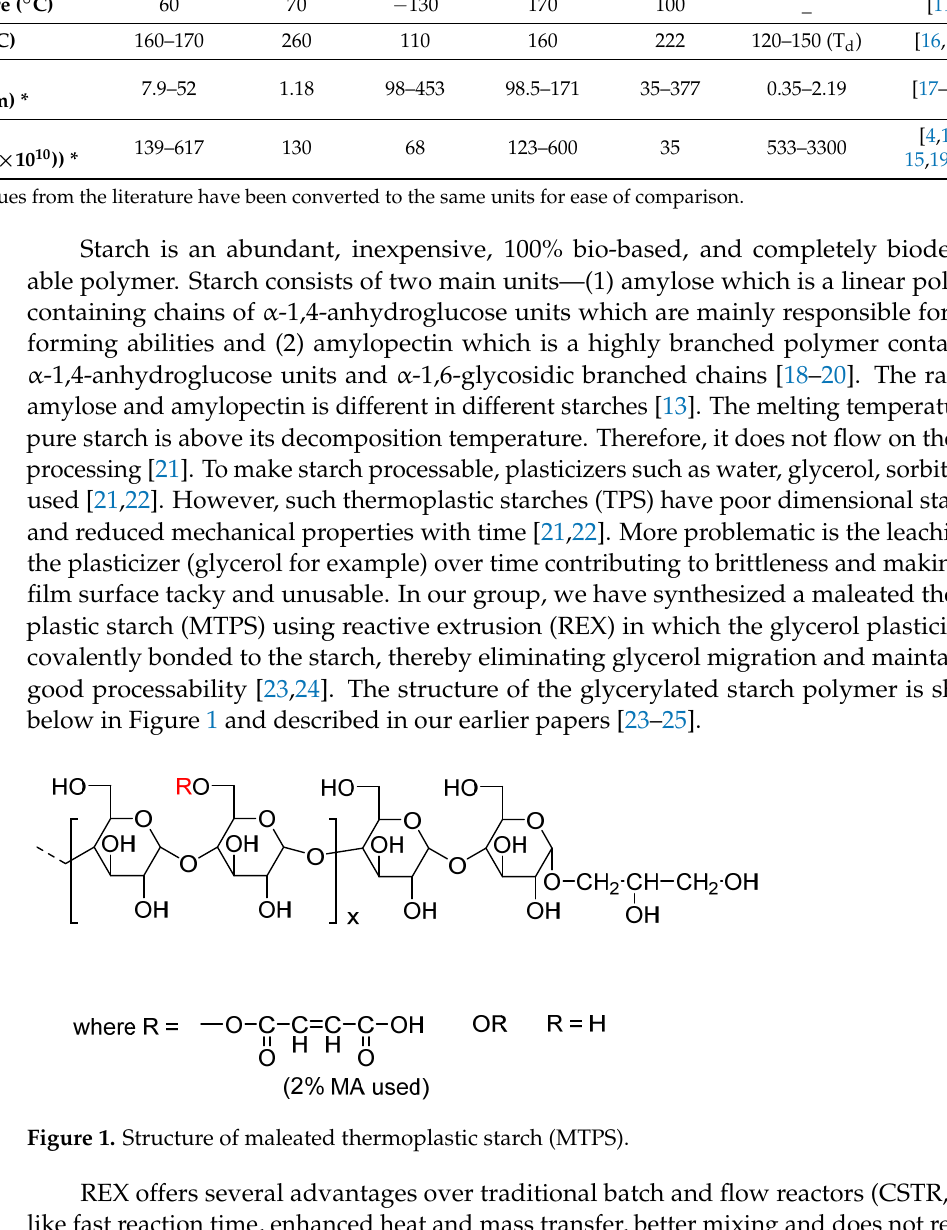
Table 1. Summary of physico-mechanical properties of packaging polymers.